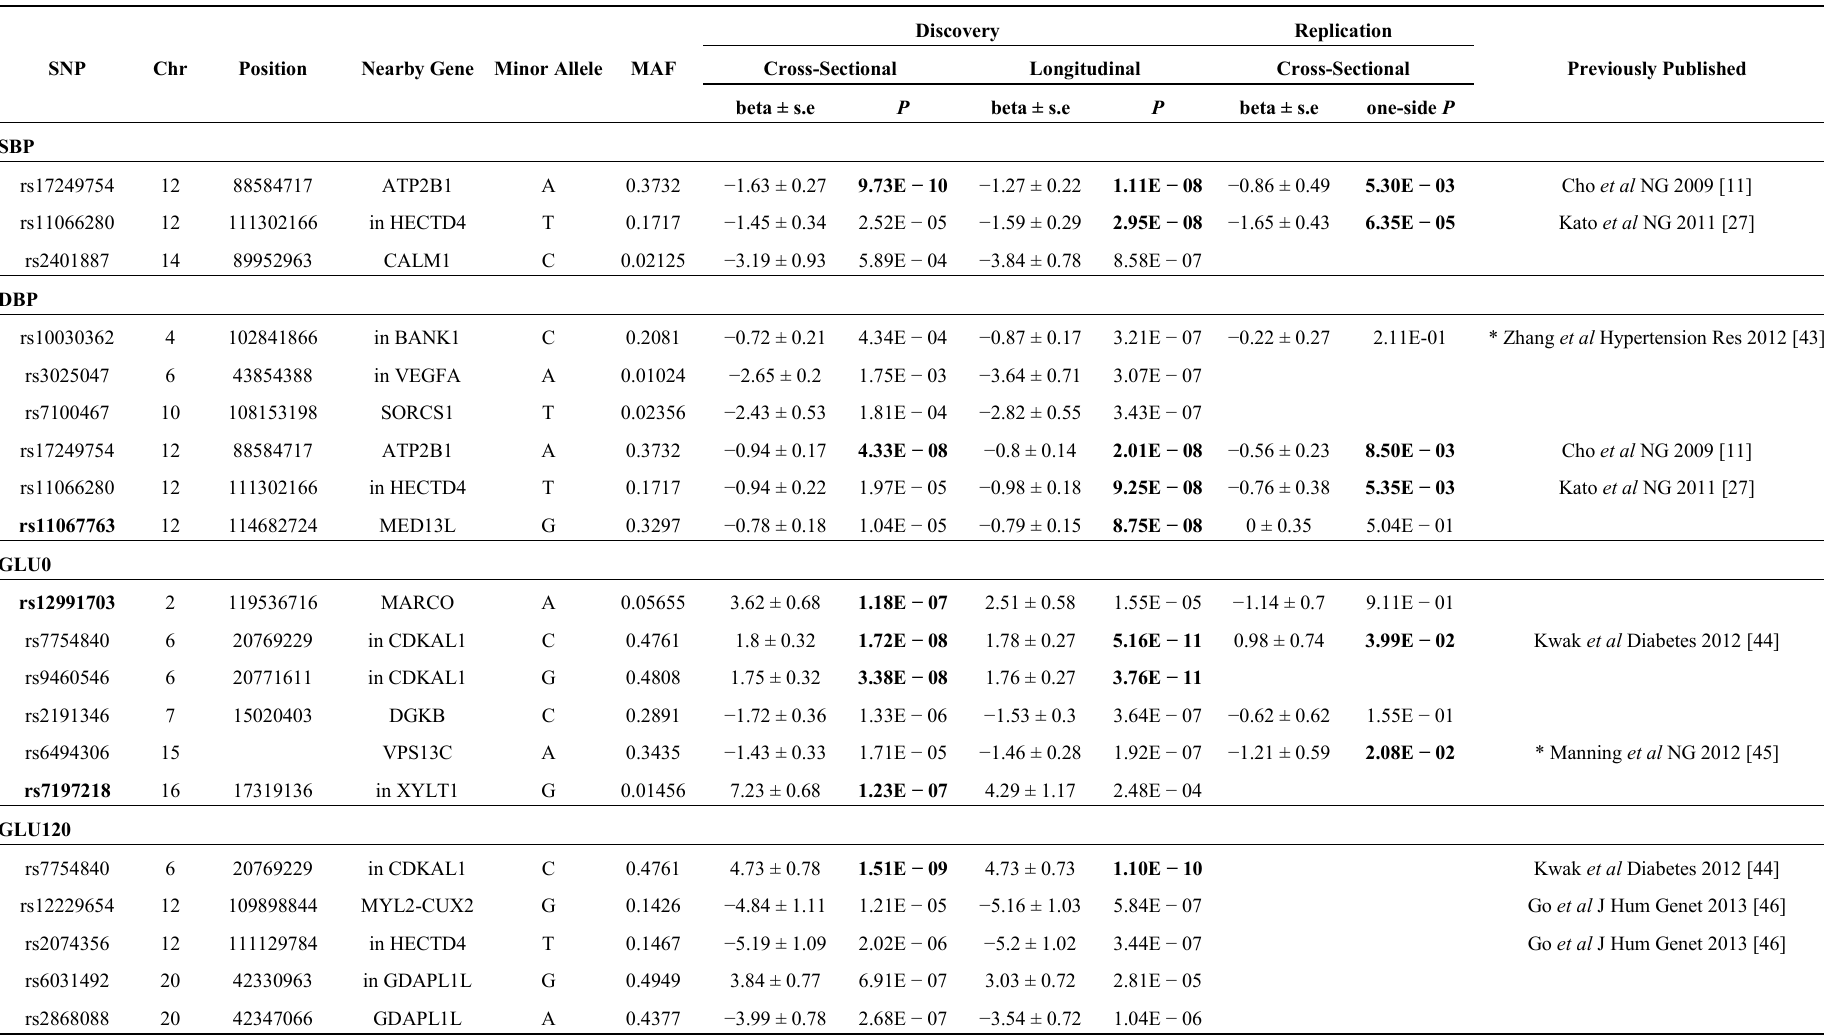
Table 5. Results for SBP, DBP, GLU0 and GLU120. SNPs with p -values less than 10 −6 from cross-sectional or longitudinal data are